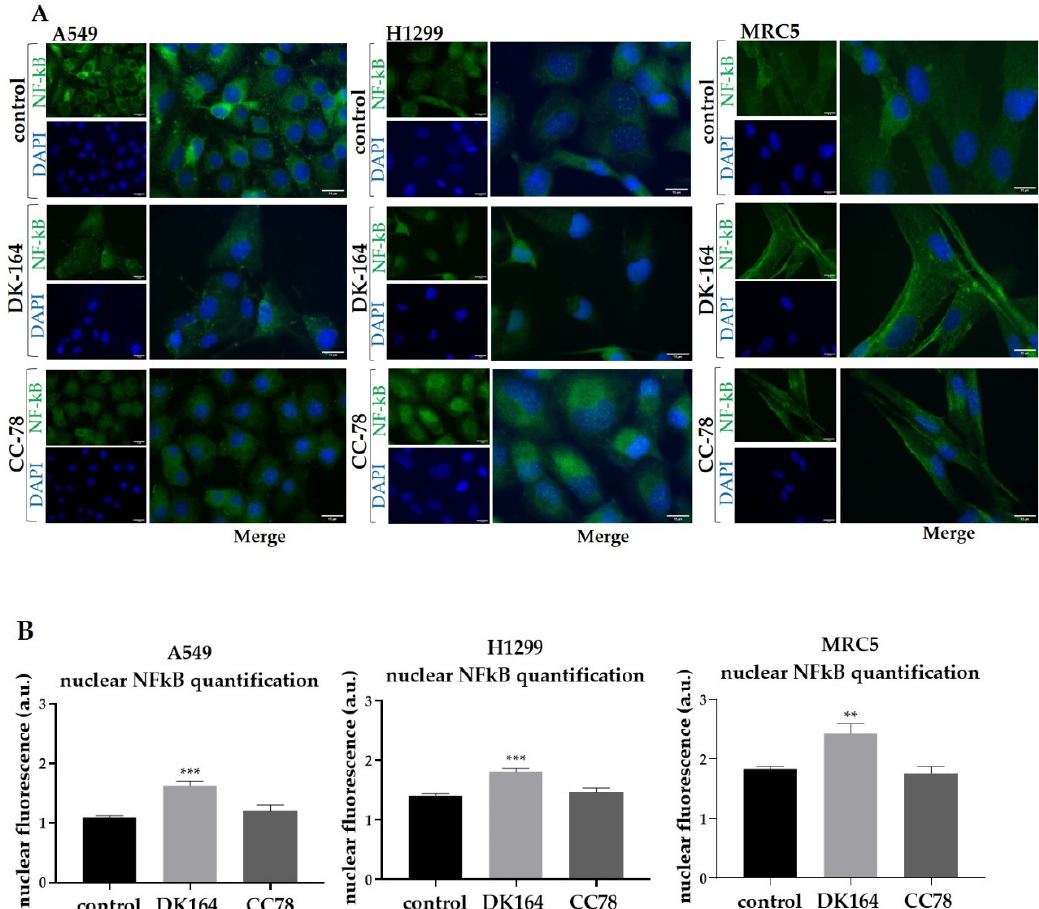
Figure 7. Activation and nuclear translocation of the NFkB protein in lung cells. ( A ) Representative immunofluorescent images of A549, H1299, and MRC5 control cells and cells treated with the calculated IC50 concentrations of DK-164 or CC-78 for 48 h and labelled with anti-NFkB antibody (green). DNA was co-stained with DAPI (blue). ( B ) Quantitative determination of the intensity of the NFkB was performed by CellProfiler cell image analysis software (Broad Institute ʹ s Imaging Platform, Cambridge, MA, USA) and GraphPad Prism v.8.0 (Dotmatics, San Diego, CA, USA). A p -value < 0.05 was considered statistically significant, ** p < 0.01, and *** p < 0.005. Quantification is based on three independent experiments with >50 cells scored for each condition. The error bars represent the standard deviation (SD). a.u.: arbitrary unit. The scale bar corresponds to 15 µ m. DK-164 treatment of A549, H1299, and MRC5 cells for 48 h increased the fluorescence signal of the NF κ B protein in the nucleus by 1.4 times in all three cell lines. Of partic- ular interest is the result for the modified compound CC-78, which did not lead to the accumulation of NF κ B in the nucleus in any of the three cell